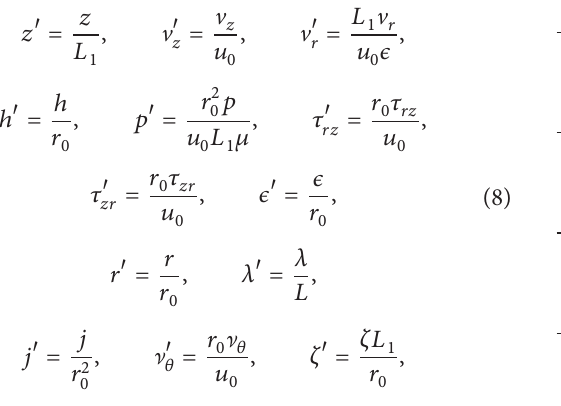
𝜙 Location of 𝑧